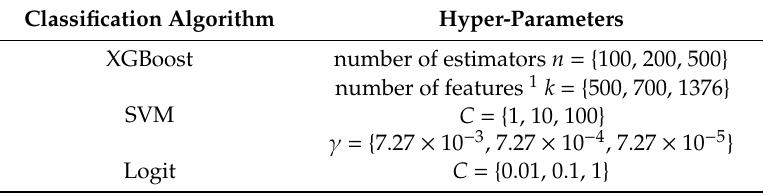
Table A1. Hyper-parameter values considered in the grid-search algorithm.